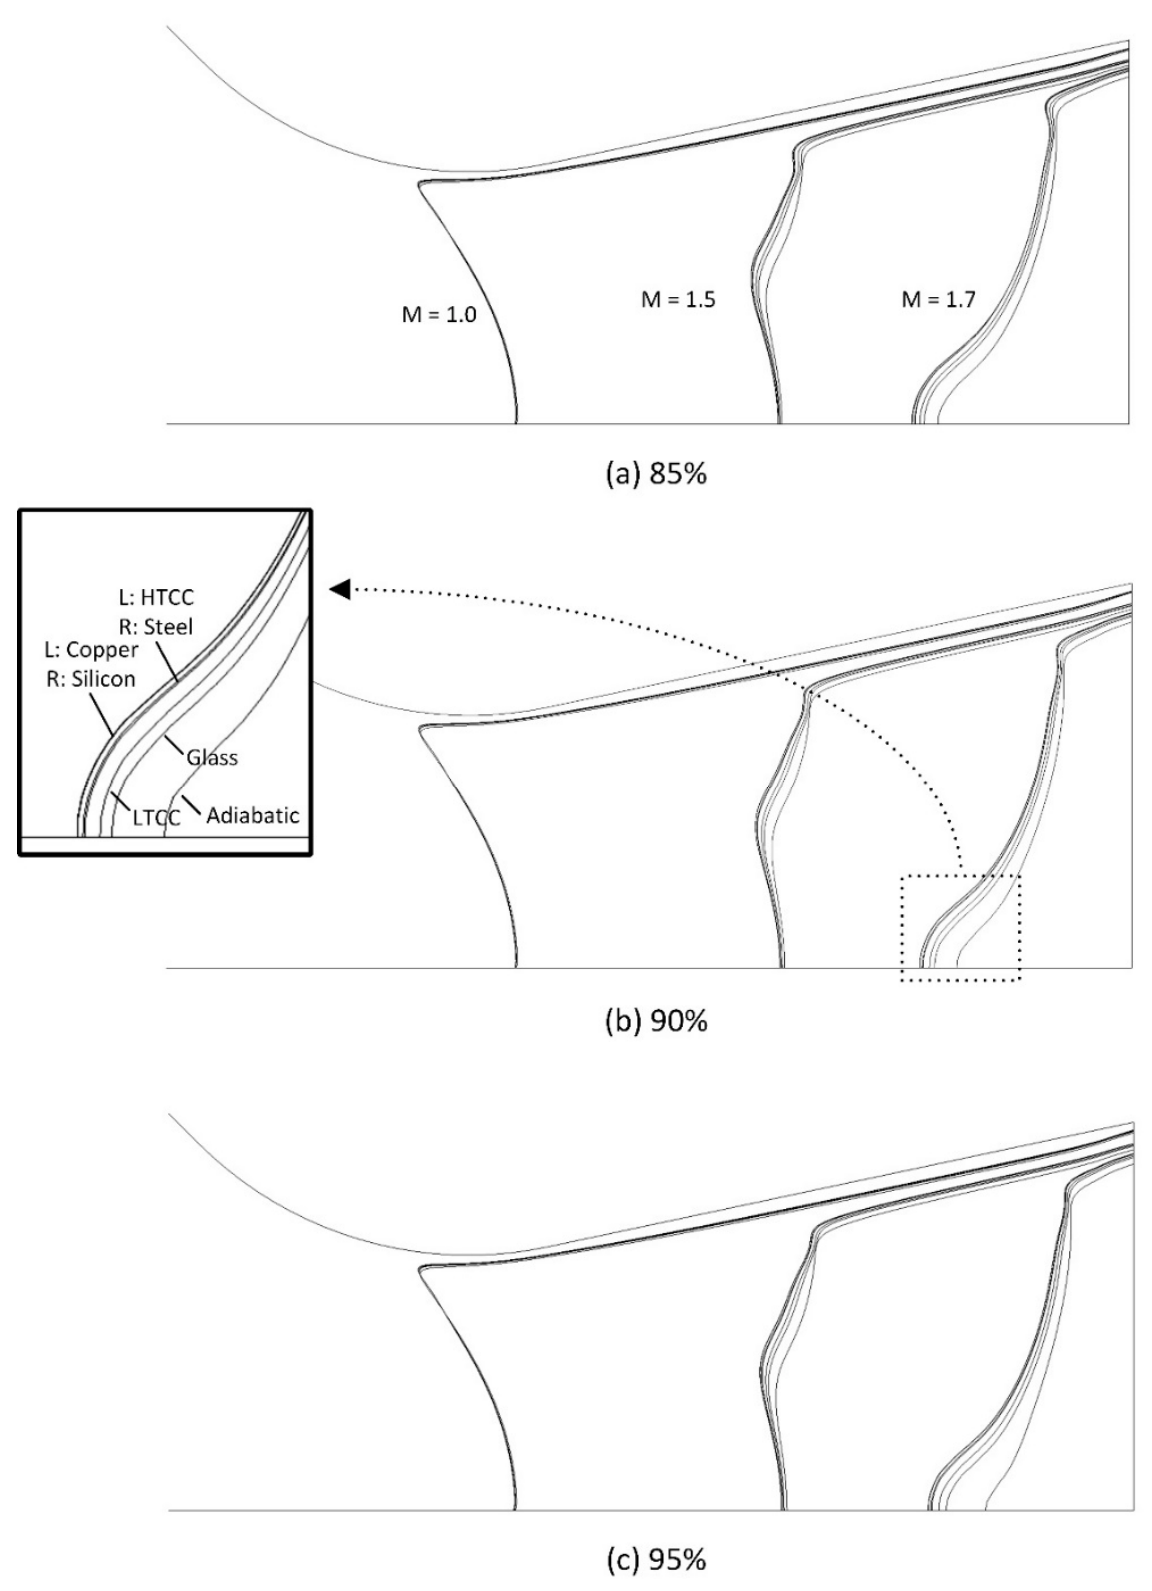
Figure 10. Mach number contours of a microthruster composed of different materials, using decom- posed gas mixtures of 85, 90, and 95 wt% hydrogen peroxide (‘L’: left-hand side, ‘R’: right-hand side for the overlapped curves).